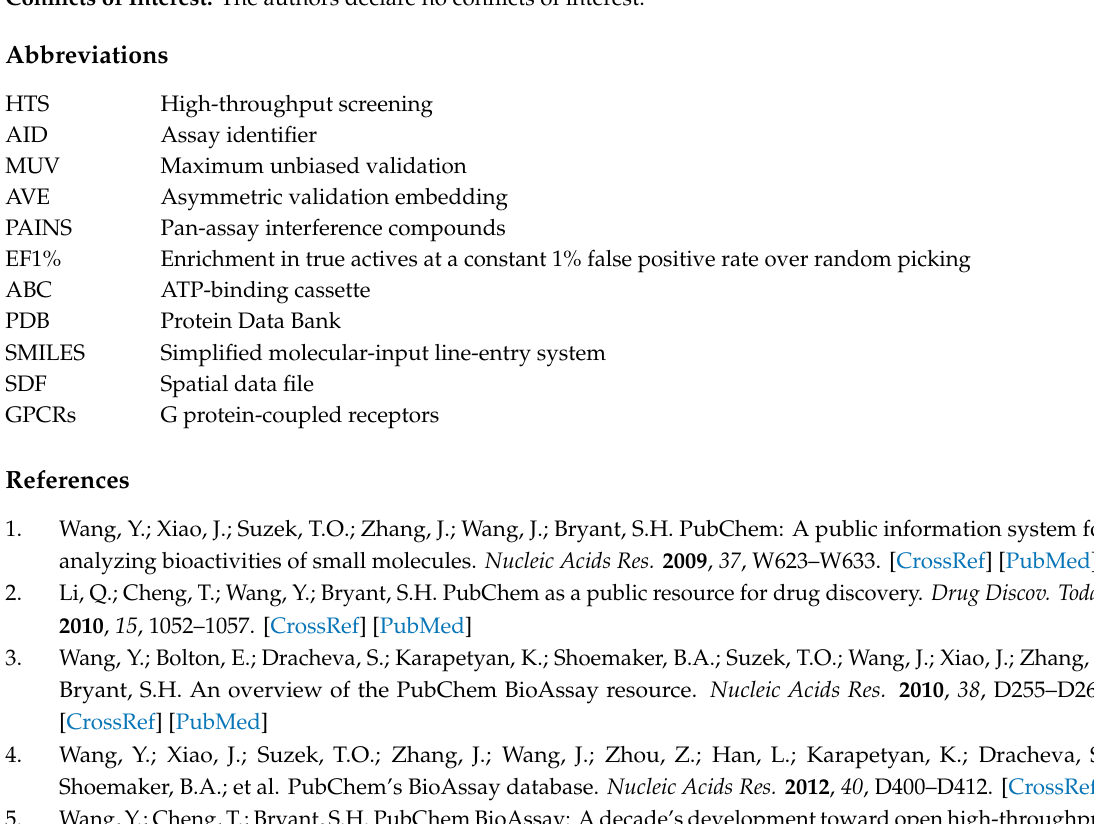
s1. Table S1. Number of PubChem bioactivity assays according to the number of tested substances, the number of active substances, the screening stage, and the target type. Statistics were updated as of 30 April 2020. Table S2. Number of compounds featured in PubChem bioactivity assays that satisfy each criterion of the Lipinski’s rule of five, the Ghose filter, and Veber’s rule. Statistics were updated as of 30 April 2020. Table S3. Sca ff old clusters of PubChem BioAssay active ligands (AID 493208) and the number of their representatives before and after LIT-PCBA filters. Table S4. Sca ff old clusters of PubChem BioAssay inactive ligands (AID 493208) and the number of their representatives before and after LIT-PCBA